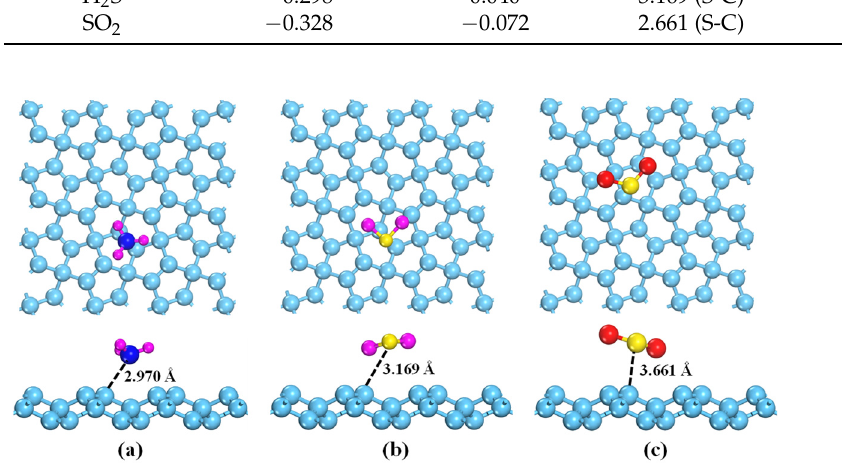
Figure 2. The lowest-energy structures of gas molecules adsorbed on pristine PG: ( a ) NH 3 , ( b ) H 2 S, and ( c ) SO 2 . The light blue, purple, dark blue, yellow, and red balls are C, H, N, S, and O atoms, respectively.